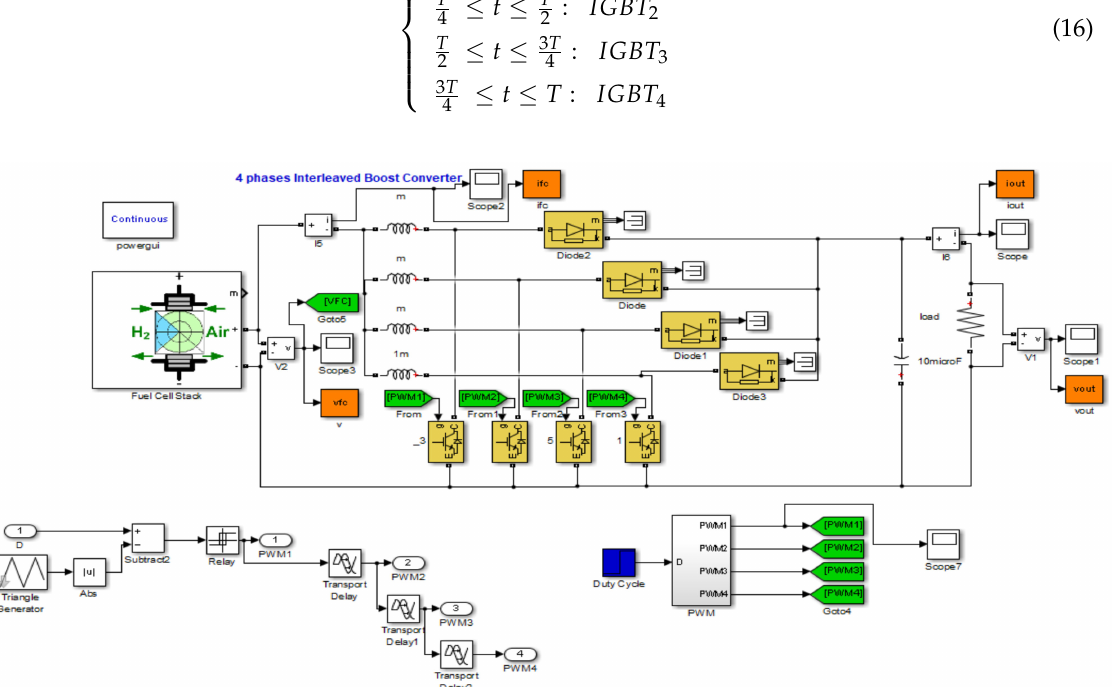
Figure 3. Interleaved Boost Converter and PWM simulation under